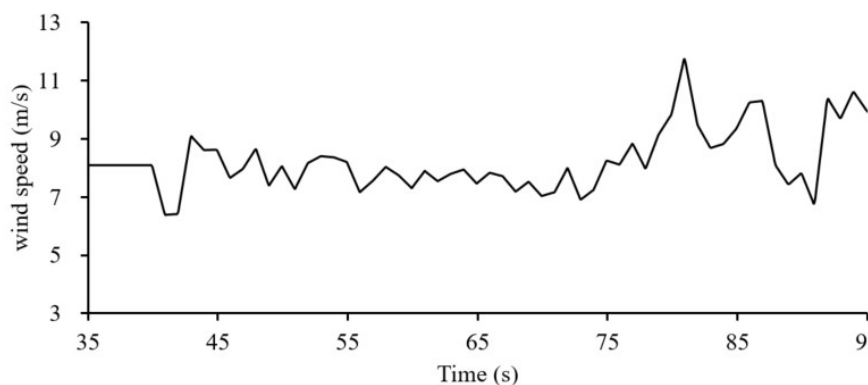
Figure 16. Wind speed for Case 4.